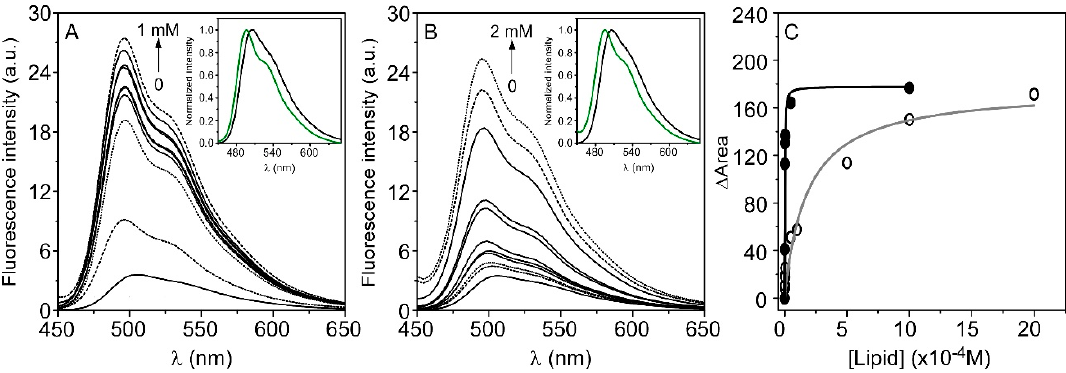
Figure 3. Fluorescence emission spectra of HTMA-PFBT (1.5 µM) in buffer and at increasing concentrations of LUVs of PG ( A ) and PC ( B ). Insets in both ( A , B ) represent the normalized fluorescence emission spectra of HTMA-PFBT in buffer (black) and incorporated in LUVs (green). (All recorded upon λ exc = 425 nm). ( C ) Area of the fluorescence emission spectrum of HTMA-PFBT at different concentrations of LUVs of PG (black circles) and PC (hollow circles).